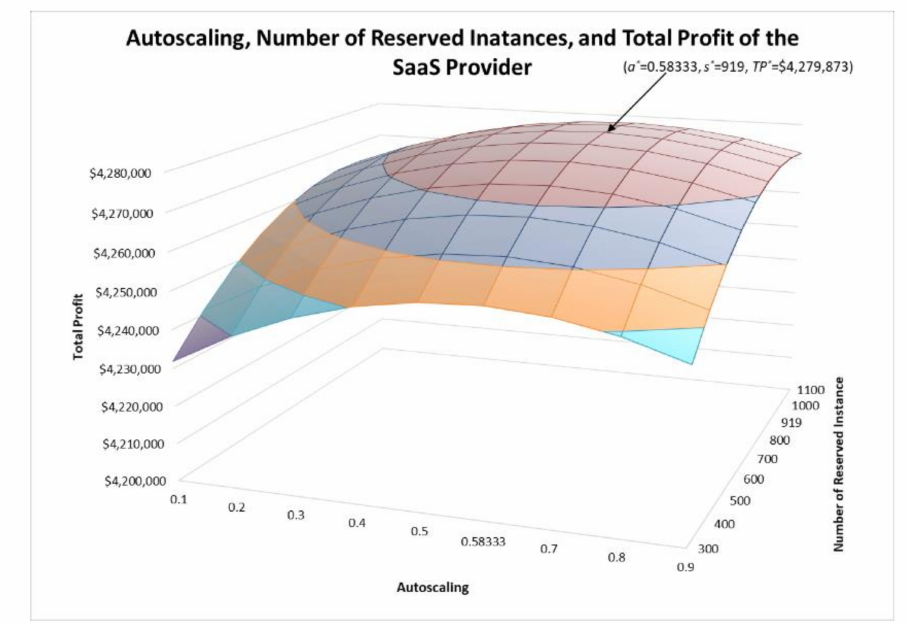
Figure 2. Autoscaling Weight of On-demand by the SaaS Provider and the Total